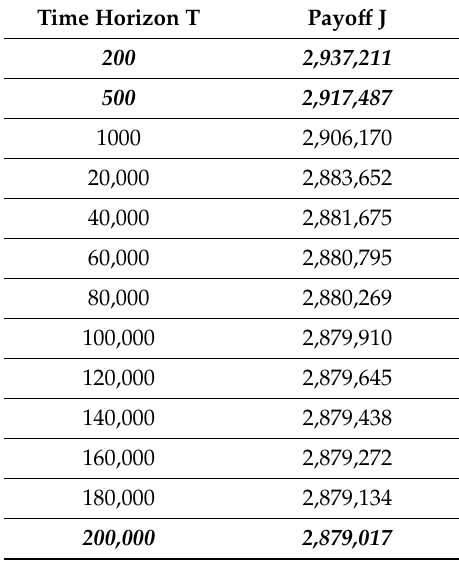
Table 3. Checking qualitative representativeness conditions for scenarios in model